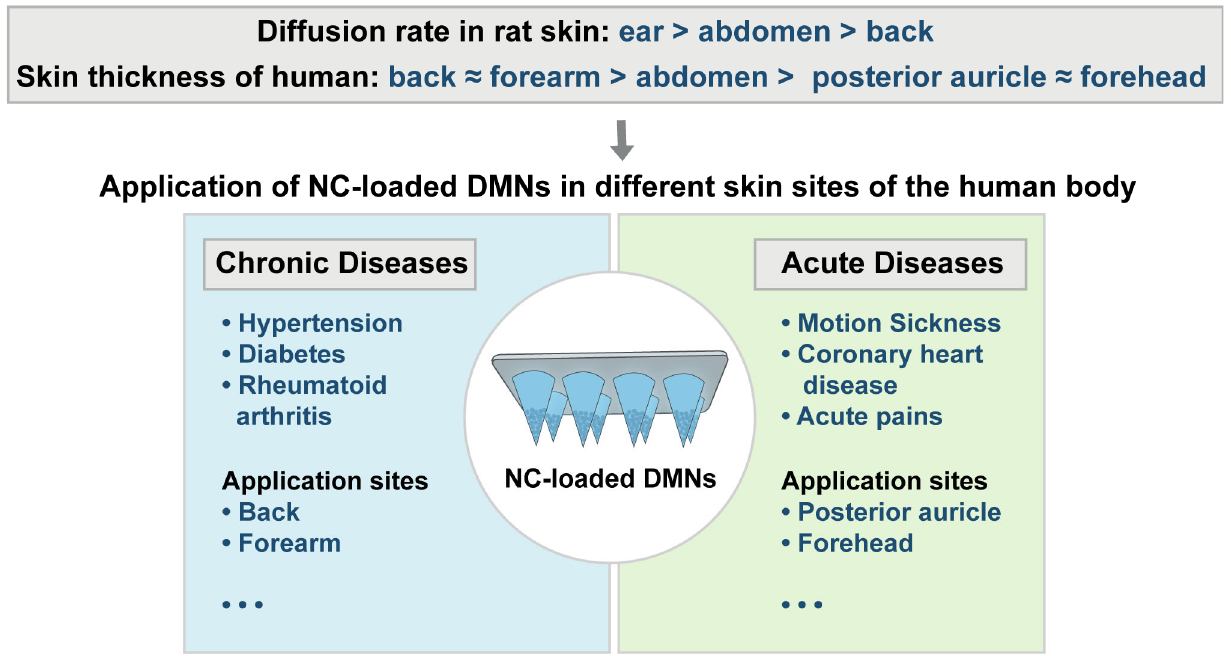
Figure 6. Potential application of NC ‐ loaded DMNs at different skin sites.